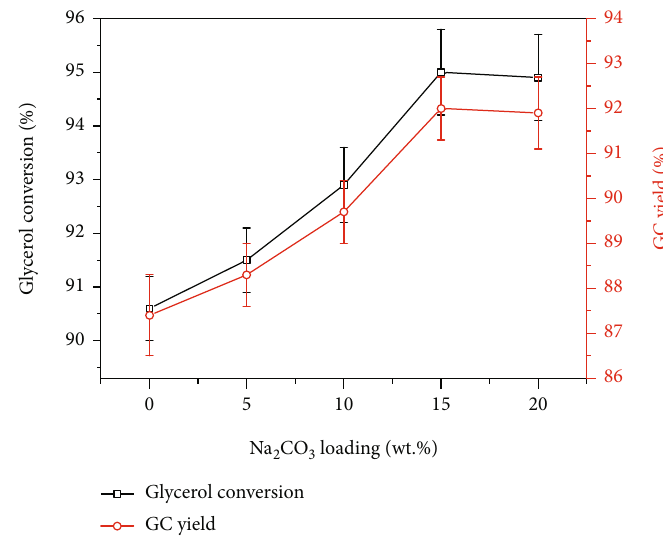
Figure 1: E ff ect of Na